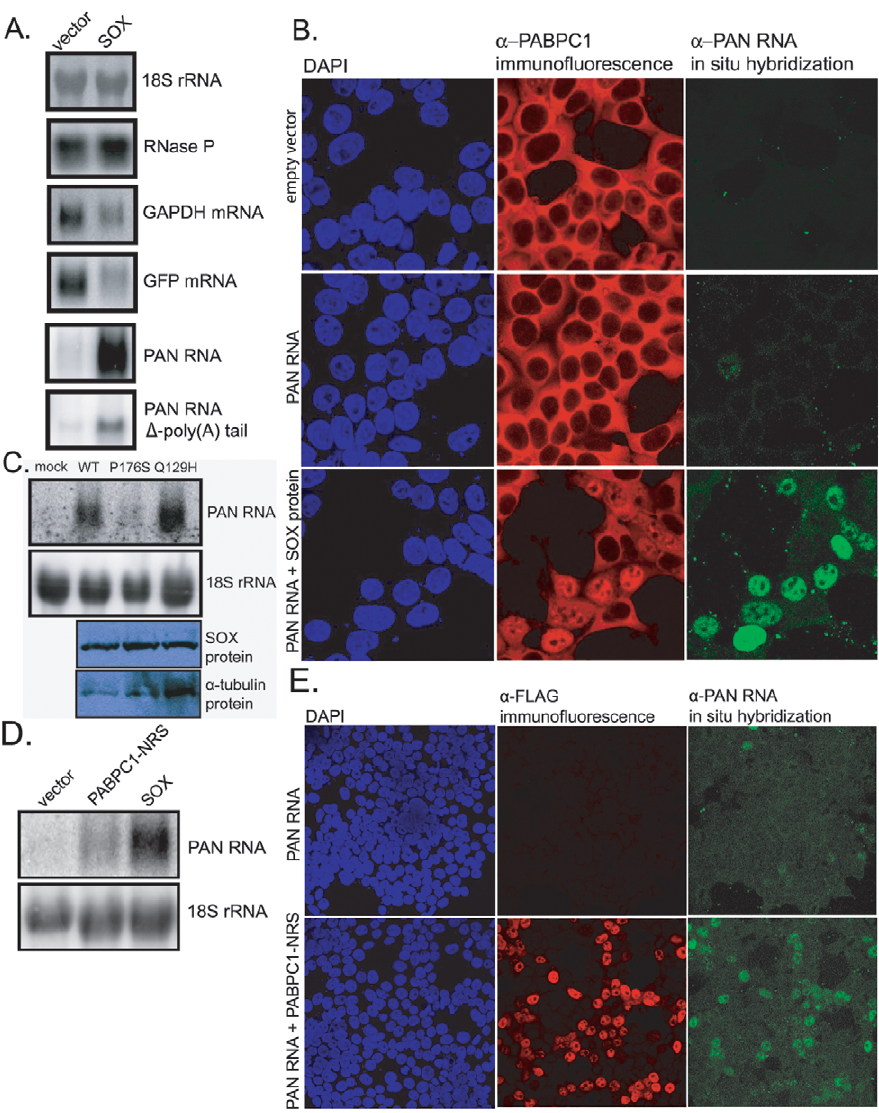
Figure 2. SOX stimulates PAN RNA expression in transient transfection assays. A. Northern blot analysis of total RNA extracted from 293 tet-on cells transfected with: 1) a GFP expression vector, 2) a PAN RNA or PAN/U7 3 9 -end (PAN RNA D -poly(A) tail) expression vector driven from a tetracycline-regulated promoter, and 3) either blank DNA (left lanes) or a SOX-expression vector (right lanes). The blot was sequentially probed for the RNAs listed on the right. B. Confocal images of dual immunofluorescence/in situ hybridization staining for PABPC1 (red) and PAN RNA (green) in transiently transfected 293T cells. Cells were transfected with: 1) empty plasmid (top panels), 2) a PAN RNA expression vector driven from the endogenous RTA-responsive PAN promoter and an RTA expression vector (middle panels), or 3) a PAN RNA expression vector driven from the endogenous RTA-responsive PAN promoter, an RTA expression vector and a SOX-expression vector (bottom panels). C. Top two panels: northern blot analysis for 18S or PAN RNA in total RNA extracted from 293T cells transfected with: 1) PAN RNA driven from its endogenous promoter, 2) an RTA expression vector, and 3) either empty plasmid, an expression vector for wild-type SOX, the P176S mutant SOX or the Q129H mutant SOX. Bottom two panels: western blots showing equal levels of expression of all three SOX proteins. D. Northern blot analysis of total RNA extracted from 293T cells transfected with an RTA expression vector, a PAN RNA expression vector driven from the endogenous PAN promoter and either blank DNA (left lane), a PABPC1-NRS expression vector (center lane) or a SOX expression vector (right lane). E. Confocal images of dual immunofluorescence/in situ hybridization staining for FLAG-tagged PABPC1-NRS (red) and PAN RNA (green) in transiently transfected 293T cells.